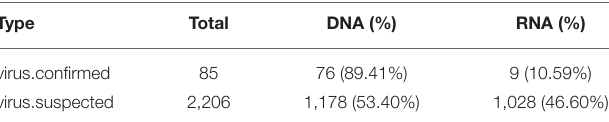
TABLE 5 | Virus category statistics.